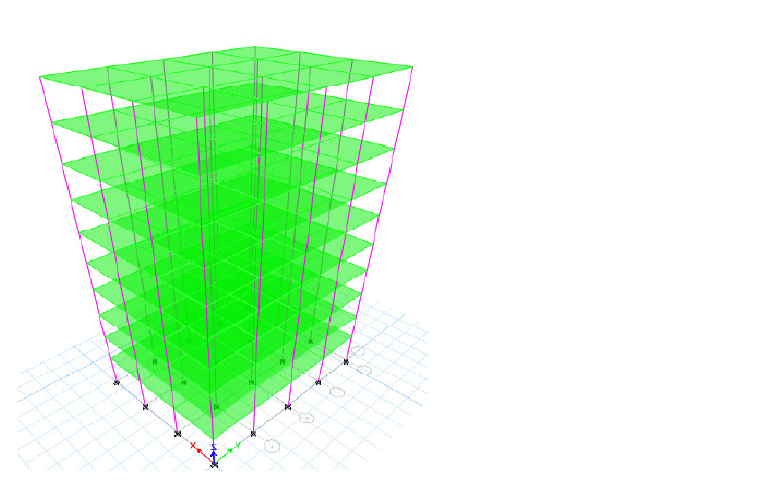
Figure 3. RC structure modelling by ETABS software.